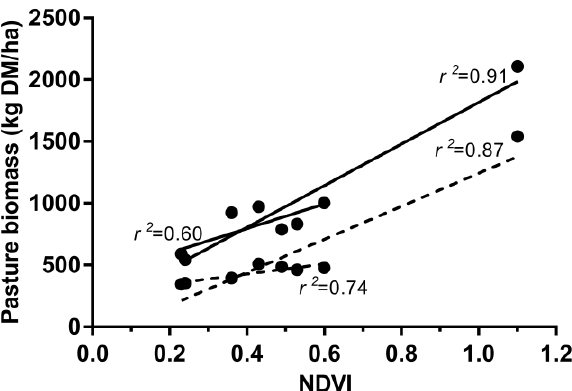
Figure 2. Correlation between total pasture biomass (solid lines) and green pasture biomass (dashed lines) with NDVI (Normalised Difference Vegetation Index). Please refer to section 3.1 in the main text for explanations between the short and long regressions curves.